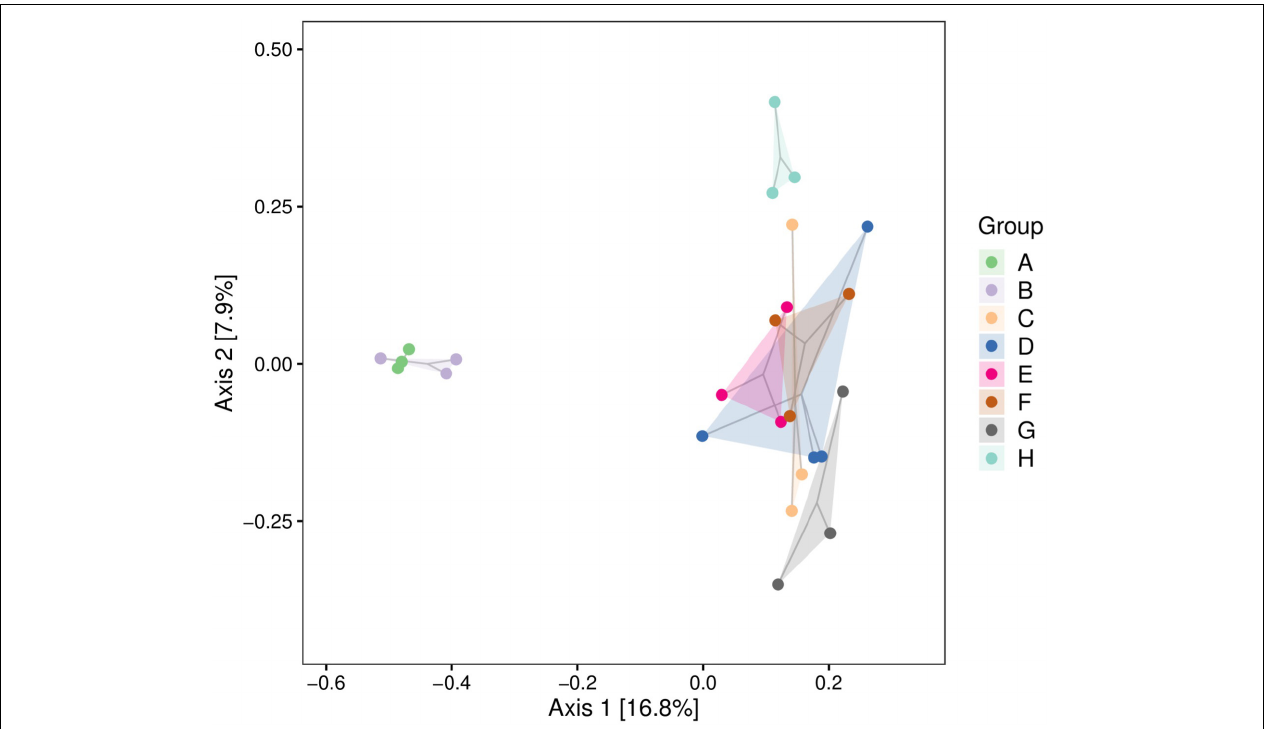
FIGURE 3 | Principal coordinates analysis (PCoA) plot of raw milk samples used in this study. A. Heilongjiang, B. Inner Mongolia, C. Gansu, D. Henan, E. Anhui, F. Jiangsu, G. Chongqing, and H. Hunan.